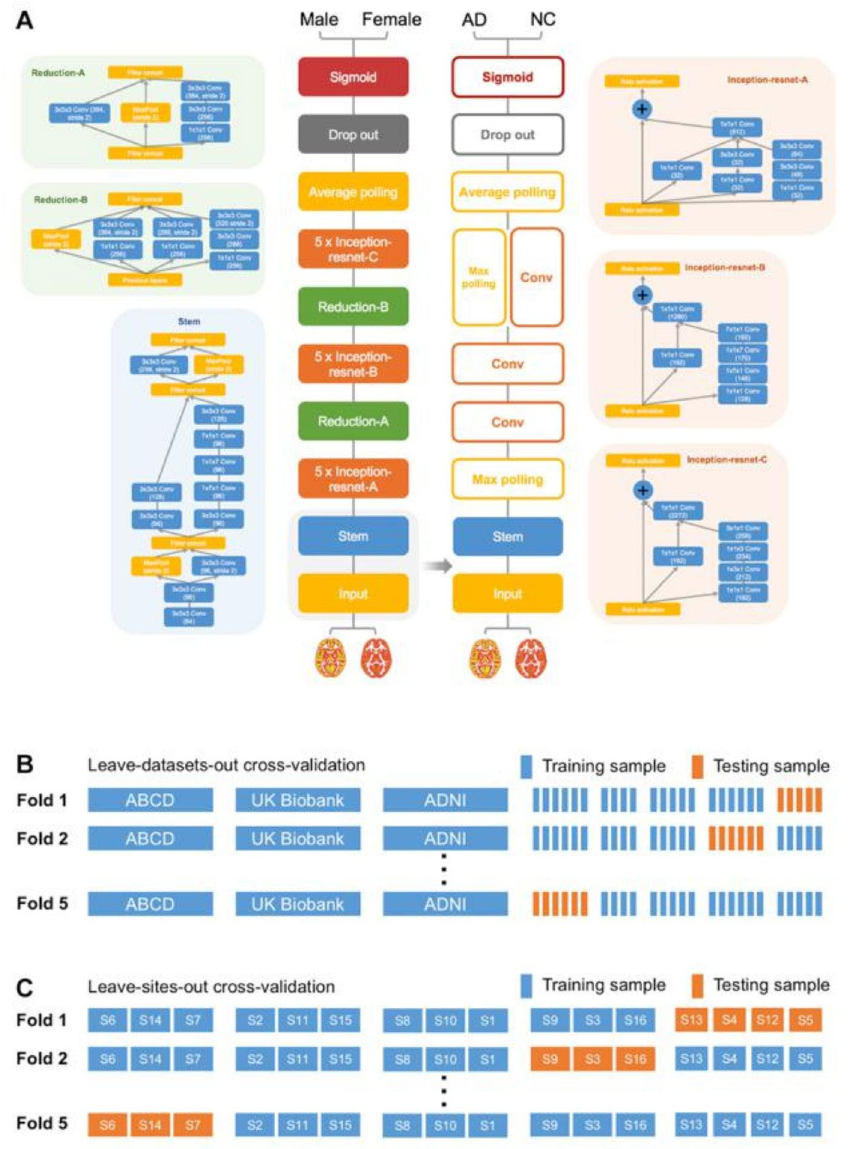
Fig. 1 Flow diagram for the Alzheimer’s disease (AD) transfer learning framework and cross-validation procedure. ( A ) Schema for the 3D Inception-ResNet-V2 model and the transfer learning framework for the Alzheimer disease classifier. ( B ) Schematic diagram for the leave-datasets-out 5-fold cross-validation for the sex classifier. ( C ) Sche- matic diagram for the leave-sites-out 5-fold cross-validation for the AD